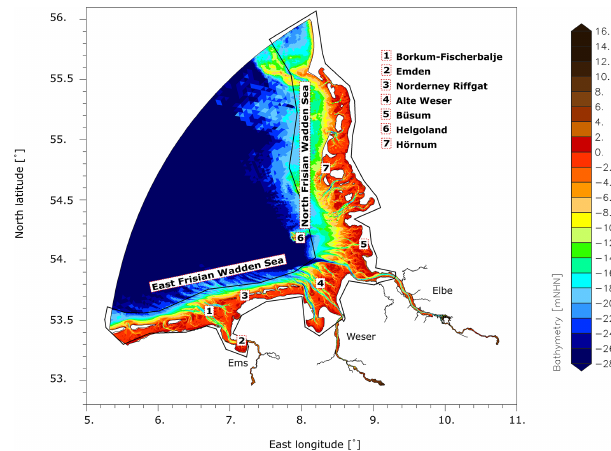
Figure 2. Model domain of the German Bight Model. The area within the black polygon is used for spatial averaging as described in Sect.